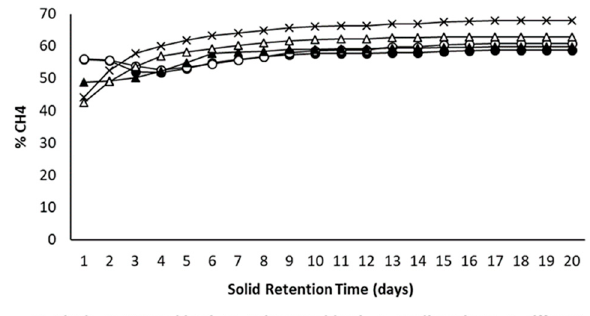
Figure 15. Methane concentration of seedling pots. Table 2. Solids analysis of seedling pots used for anaerobic digestion.